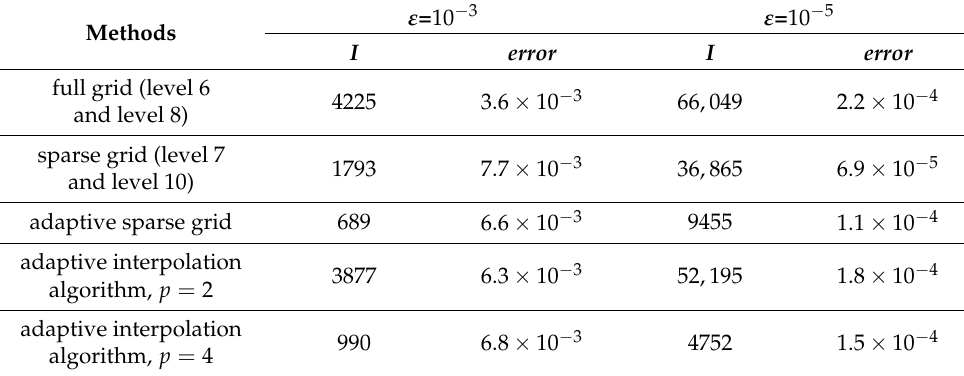
Table 1. Comparison of approaches for system given by Equation (9).